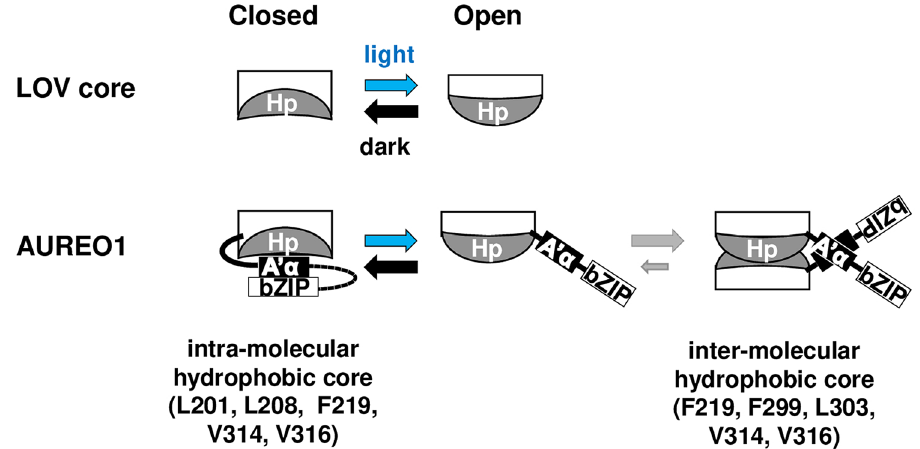
Figure 7. The closed-open conformational equilibrium of the LOV core (top). The equilibrium is shifted toward the closed conformation in the dark state and toward the open conformation in the presence of BL. Hp indicates the hydrophobic region in the β -sheet. In AUREO1 (bottom), the closed conformation is stabilized by intramolecular hydrophobic interactions involving L201, L208, and L212 in the A’ α helix and F219, V314, and V316 in the β -sheet. BL shifts the equilibrium of the LOV core toward the open conformation and deforms the hydrophobic surface of the β -sheet containing F219, V314, and V316, subsequently inducing the detachment of the A’ α helix and the dimerization of AUREO1. The AUREO1 dimer is stabilized by intermolecular hydrophobic interactions involving F219, F299, L303, V314, and